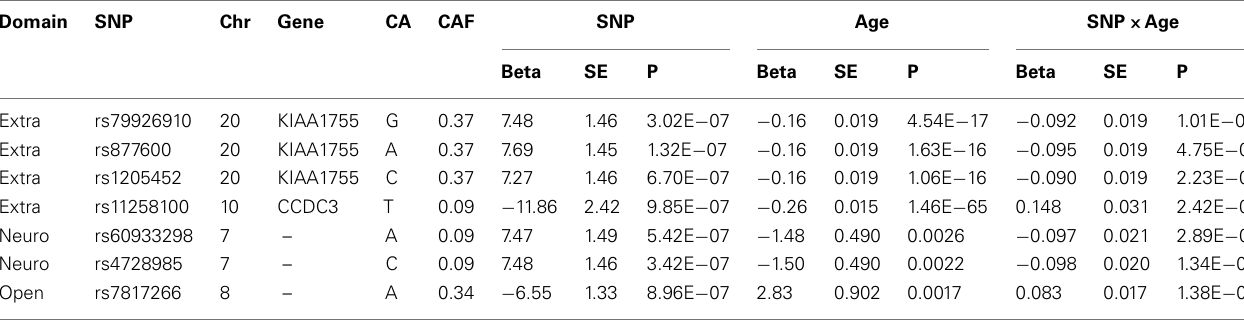
Table 4 | SNPs with significant interaction with